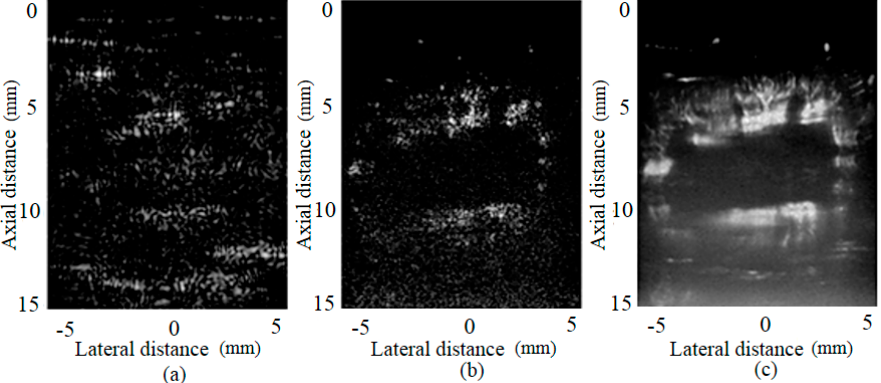
Figure 3. The imaging results of rabbit kidney using: ( a ) DAS, ( b ) DAS + wall filter, and ( c ) DAS + wall filter + Gaussian PSF deconvolution + scatter plot respectively. All images are shown with a dynamic range of 50 dB.